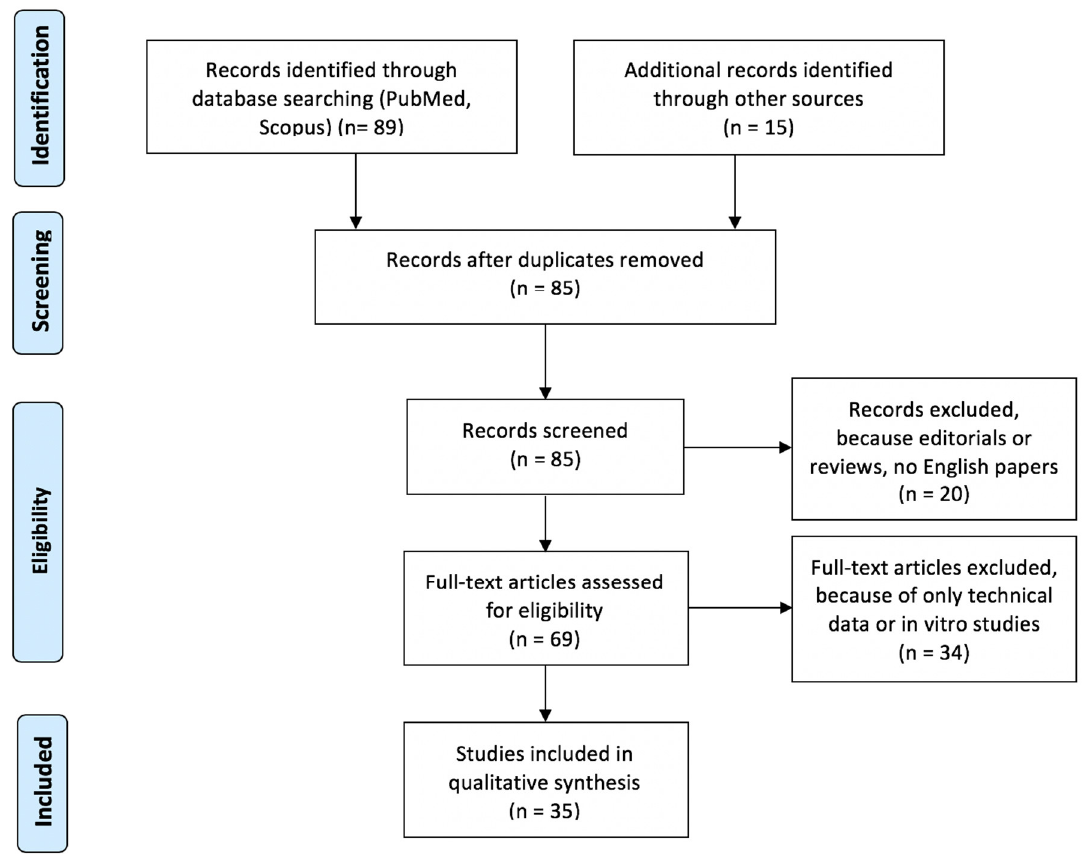
Figure 1. Preferred Reporting Items for Systematic Reviews and Meta-analyses (PRISMA) flowchart of included papers.